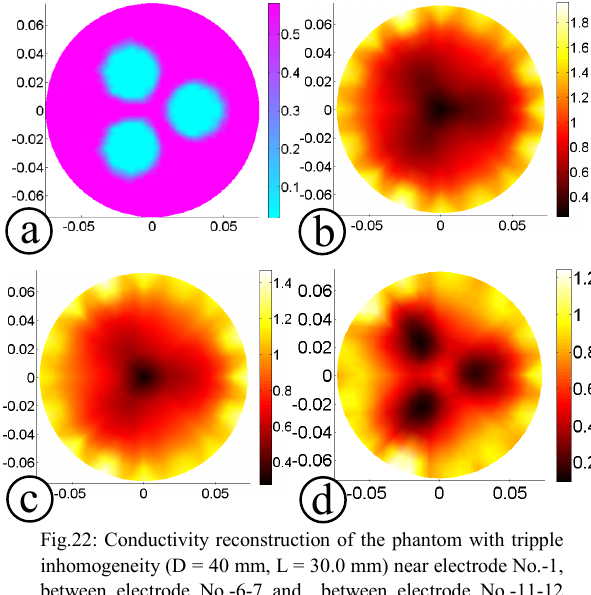
Fig.2 2: Conductivity reconstruction of the phantom with tripple inhomogeneity (D = 40 mm, L = 30.0 mm) near electrode No.-1, between electrode No.-6-7 and between electrode No.-11-12 ( λ = 0.00011): (a) original object, (b) image with STR, (c) image with LMR, (d) image with BMMR